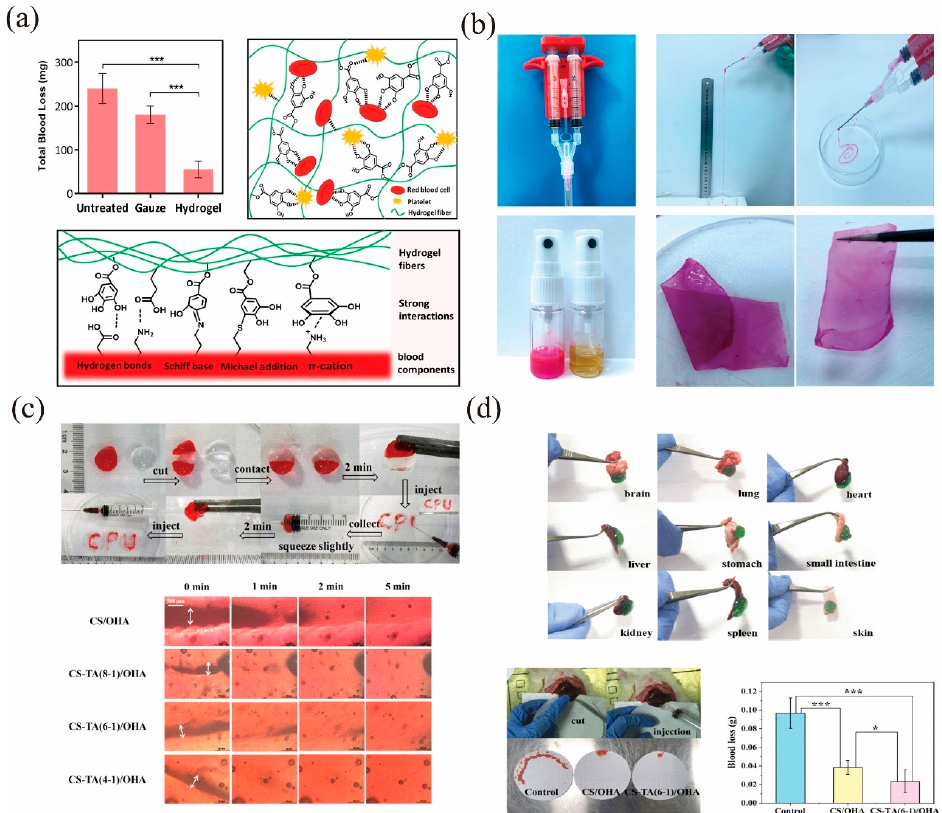
Figure 7. ( a ) Hydrogel covalent cross-linking principle, hydrogel-platelet interaction, comparison graph of wound bleeding after 180 s with and without adding hydrogel. (*** p < 0.001) ( b ) Injectable self-supporting sprayable CMCS-TA-BDBA hydrogels prepared using a double syringe [126]. Copy- right 2020 American Chemical Society. ( c ) Self-healing and injectable properties. ( d ) Photographs of CS/TA-OHA adhering to organs and tissues of rats, and the amount of bleeding in rats under different treatments (* p < 0.05; *** p < 0.001.) [112]. Copyright 2022 American Chemical